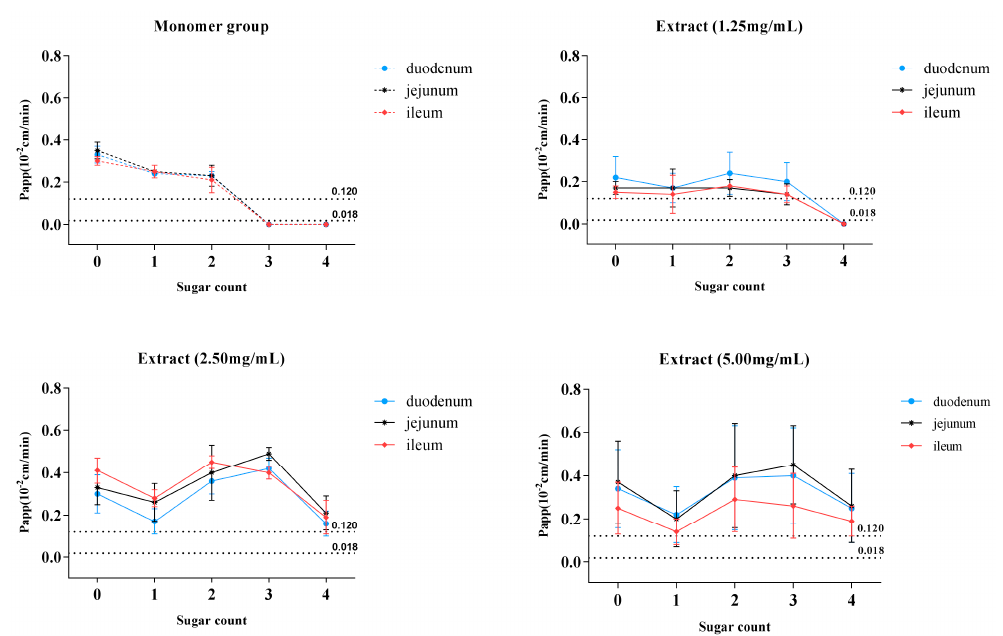
Figure 6. The relationship of saponin glycoside numbers with P app value in monomer groups and different concentration of MDQ-TS groups. ( A ) Monomers groups; ( B ) 1.25 mg · mL − 1 of MDQ-TS group; ( C ) 2.5 mg · mL − 1 of MDQ-TS group; and ( D ) 5.0 mg · mL − 1 of MDQ-TS group. By plotting the glycoside numbers of C1, C2, C3, C4, DC1, and DC2 versus their P app values, the relationships between glycoside